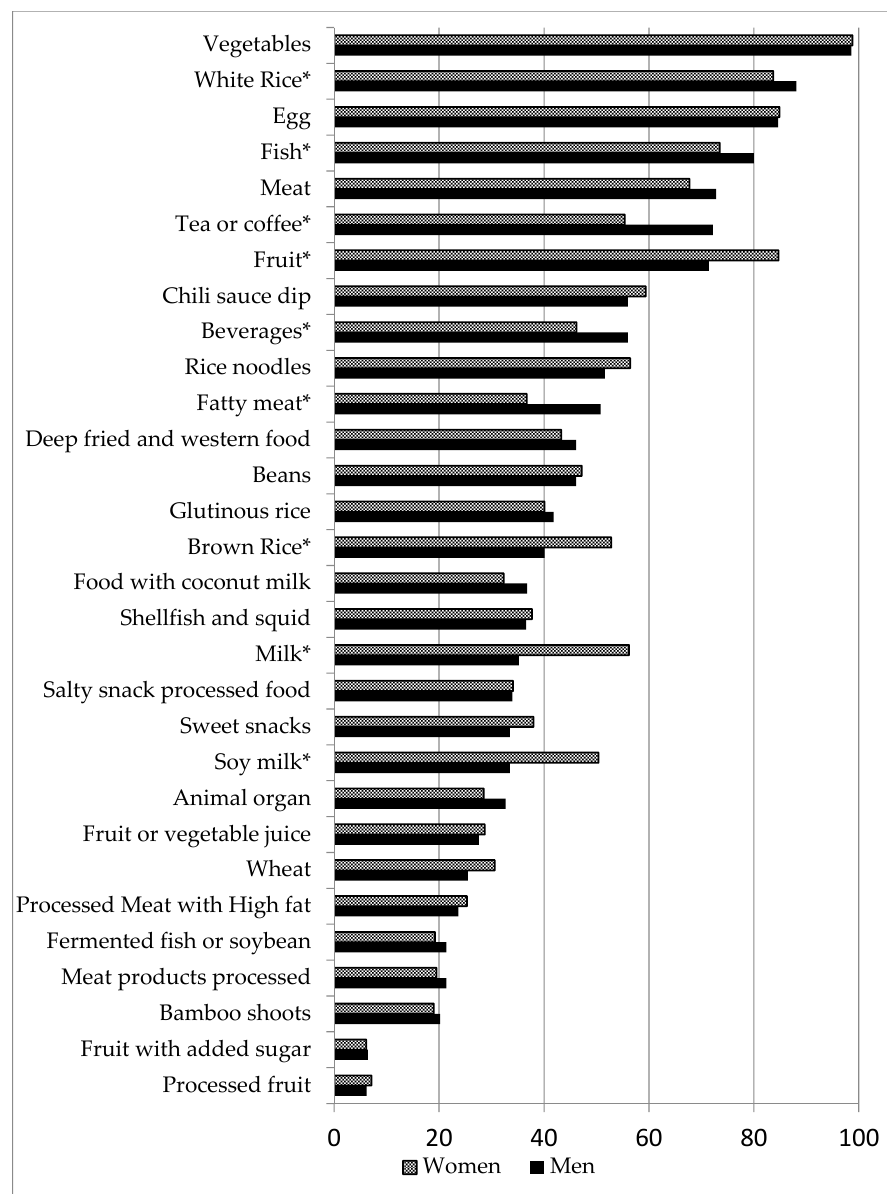
Figure 1. Percentage of Thai adults consuming each food group per week by sex. * χ 2 p value < 0.05 when comparing weekly food group consumption frequency by sex.